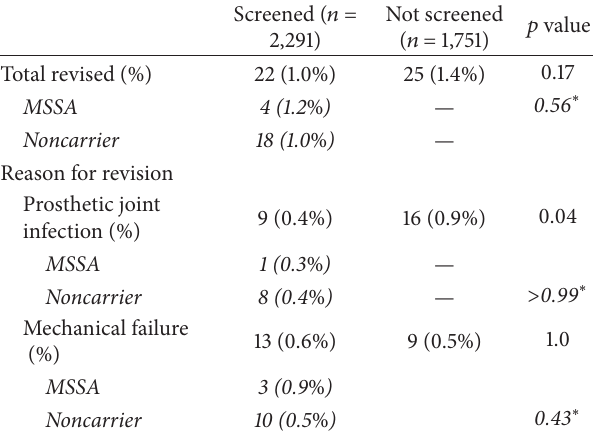
Table 2: Screening status of all total knee and total hip patients between October 2011 and March 2013 ( 𝑛 = 4,042) who subsequently underwent revision surgery ( 𝑁 = 47 ). A subgroup analysis of the screened group compared those colonized with MSSA (methicillin- sensitive Staphylococcus aureus ) with those who were noncarriers. 𝑝 values relevant tothesubgroupanalysis aredenoted with anasterisk.